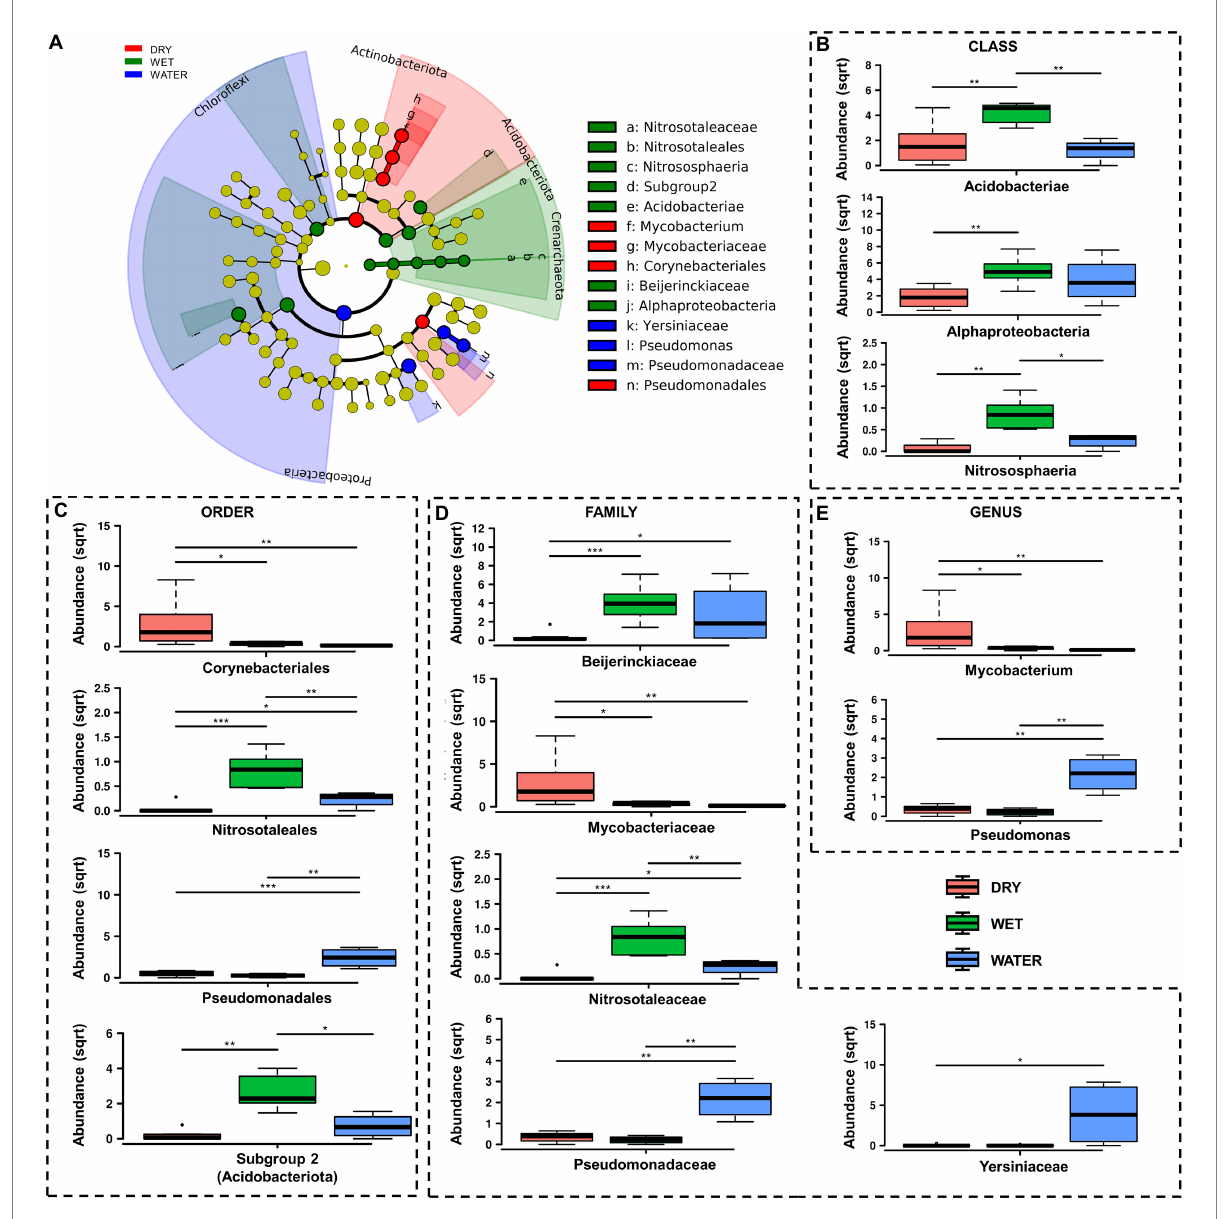
FIGURE 5 LefSe analysis of microbial communities from Imawarì Yeuta samples. (A) LefSe cladogram showing the microbial taxa (represented by the dots) with significant differences in the three groups. Red, green, and blue shades group different taxa, with the species classification at the level of phylum, class, order, family, and genus shown from the inside to the outside. The red, green, and blue nodes in the phylogenetic tree represent microbial taxa that play an important role in the DRY, WET, and WATER groups, respectively. Yellow nodes represent taxa with no significant difference. (B–E) Rank test results for classes, orders, families, and genera identified in LefSe analysis. Abundance in the y-axes stands for relative abundance. (sqrt) stands for square root transformation. The statistical significance is indicated by *, **, and *** that stand for p < 0.05, p < 0.01, and p < 0.001,